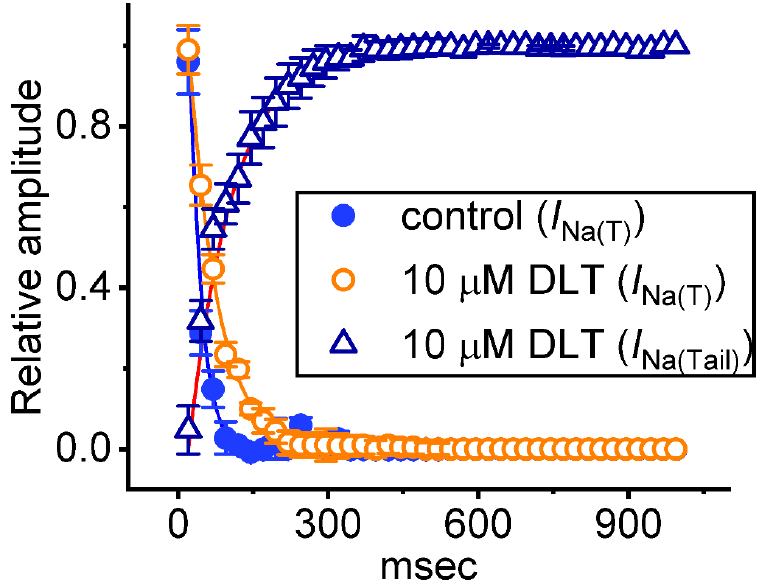
Figure 5. Relationship of I Na(T) or I Na(Tail) versus the pulse train (PT) duration in the absence (blue filled circles) and presence (orange open circles or blue open triangles) of 10 μ M DLT (mean ± SEM, n = 8 for each point). The observed I Na(T) or I Na(L) was measured as indicated in the right side of Figure 1. The continuous smooth lines, over which the experimental data points are overlaid, were optimally fitted by a single exponential (i.e., exponential decrease or increase). Notably, during PT stimulation, cell exposure to DLT can increase the decaying time constant of I Na(T) inactivation; however, it led to a progressive increase (i.e., staircase increase) in the amplitude of I Na(Tail)